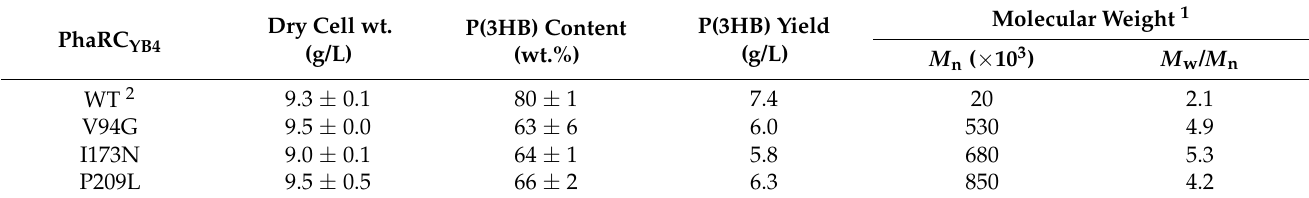
Table 4. P(3HB) accumulation in E. coli JM109 expressing mutated PhaRC YB4 . PhaRC